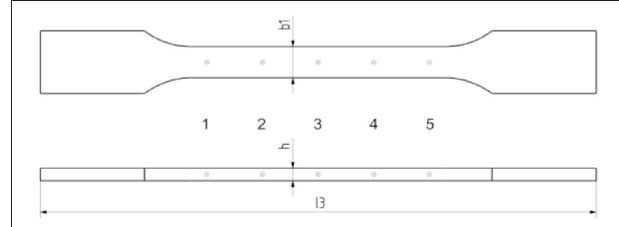
FIGURE 4 | Measuring points located on the type 1A tensile